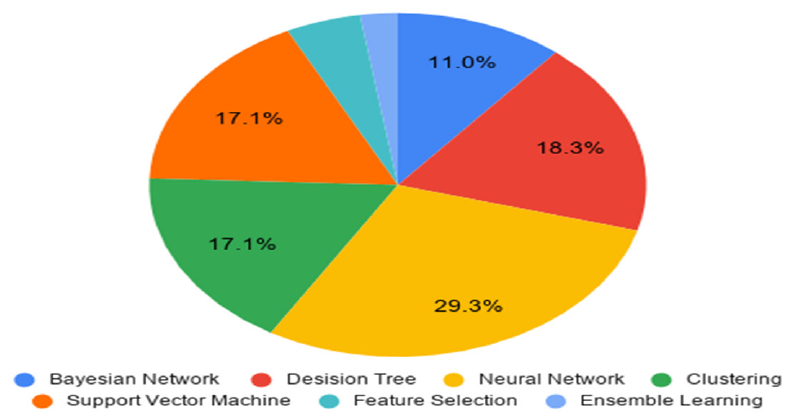
Figure 3. Distribution of machine learning techniques.